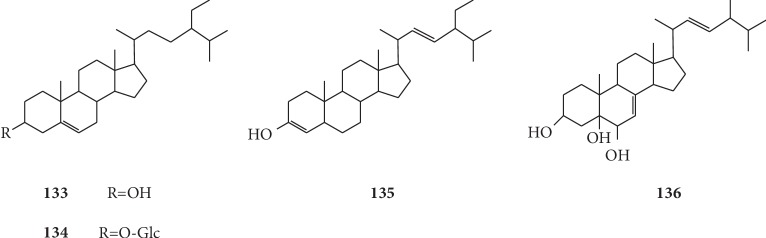
Structures of steroids in G. littoralis.